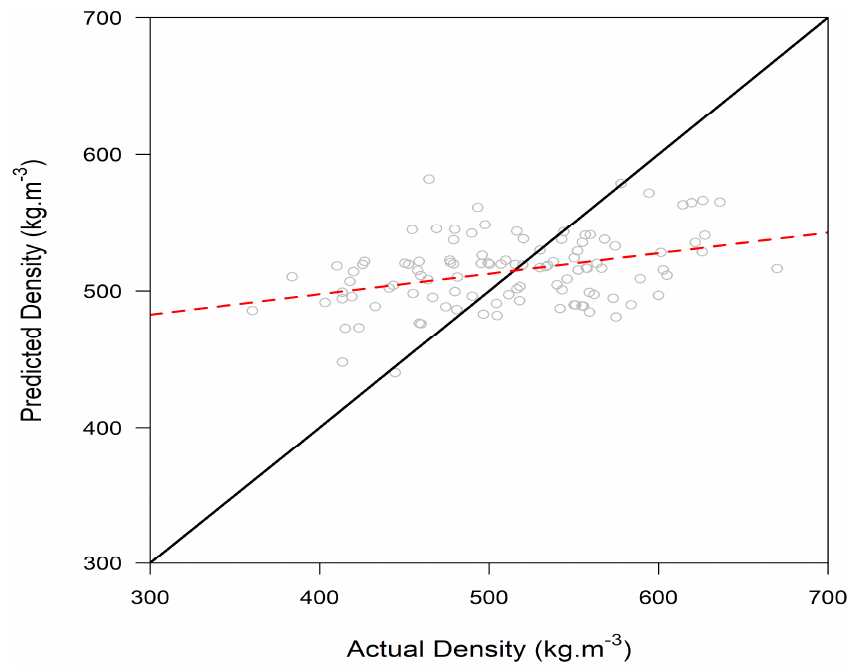
Figure 10. Predicted vs. actual values of wood density (kg · m − 3 ) for random forests model of black spruce wood density for the Hearst Forest of Northeastern Ontario (n = 109). The dashed red line is the line of best fit through the distribution.